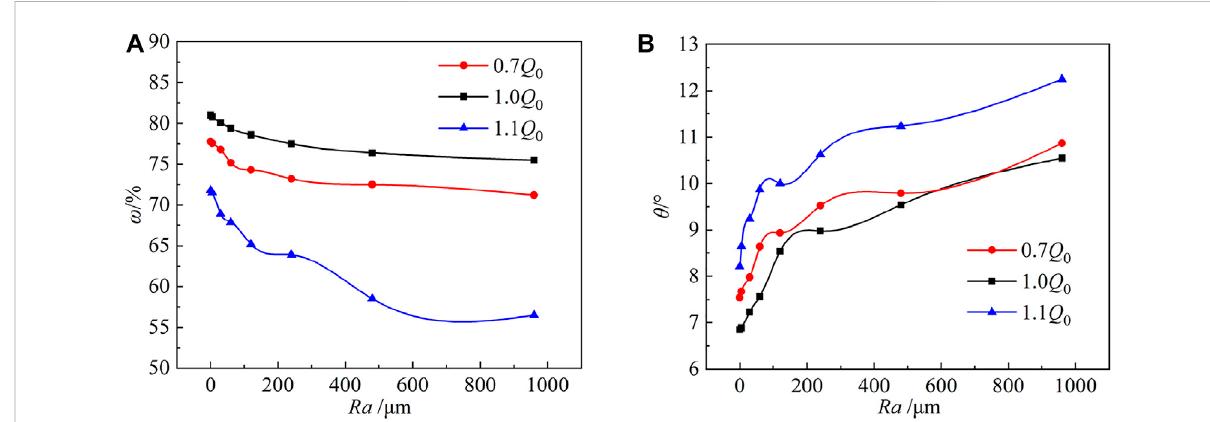
FIGURE 11 Effect of roughness on ω and θ under different fl ow rate conditions: (A) ω versus Ra and (B) θ versus Ra .